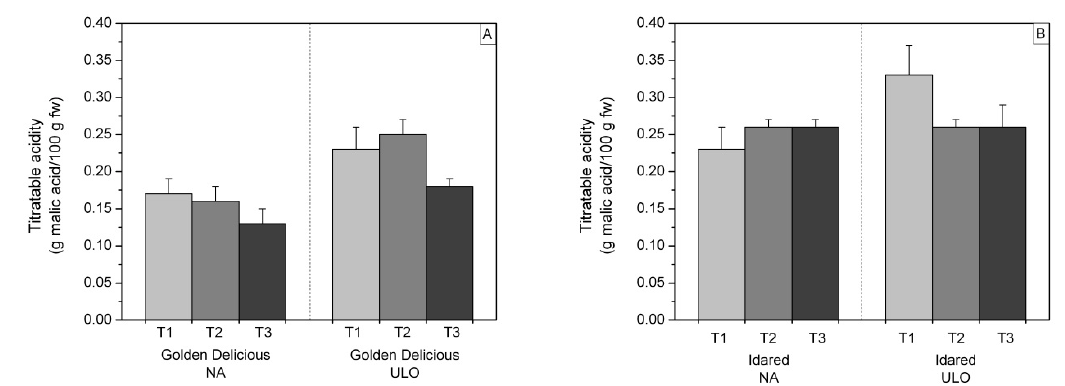
Figure 3. Impact of storage type on titratable acidity (TA) expressed in percentage (%) in ( A ) ‘Golden Delicious’ and ( B ) ‘Idared’ apples after 10 (T2) and 20 days (T3) of shelf life at 20 ◦ C. Values represent mean ± standard deviation (S.D.) of three replicates per storage type and shelf life period.